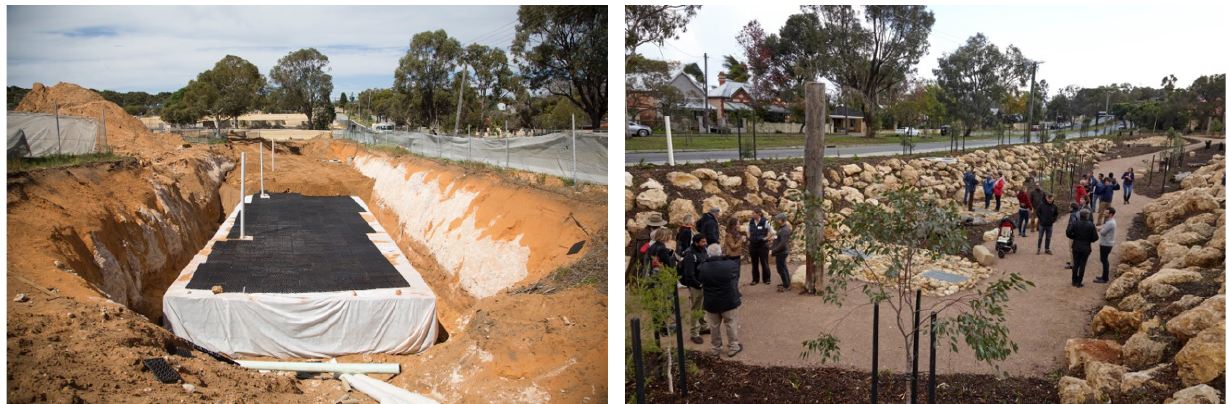
Figure 4. Left: installation of drainage cells as part of the retrofitting of the stormwater sump; right: the completed stormwa- ter sump with a newly landscaped parklet for community use. Source: LandCorp (2015). of walkways and cycle paths to encourage active, out- door